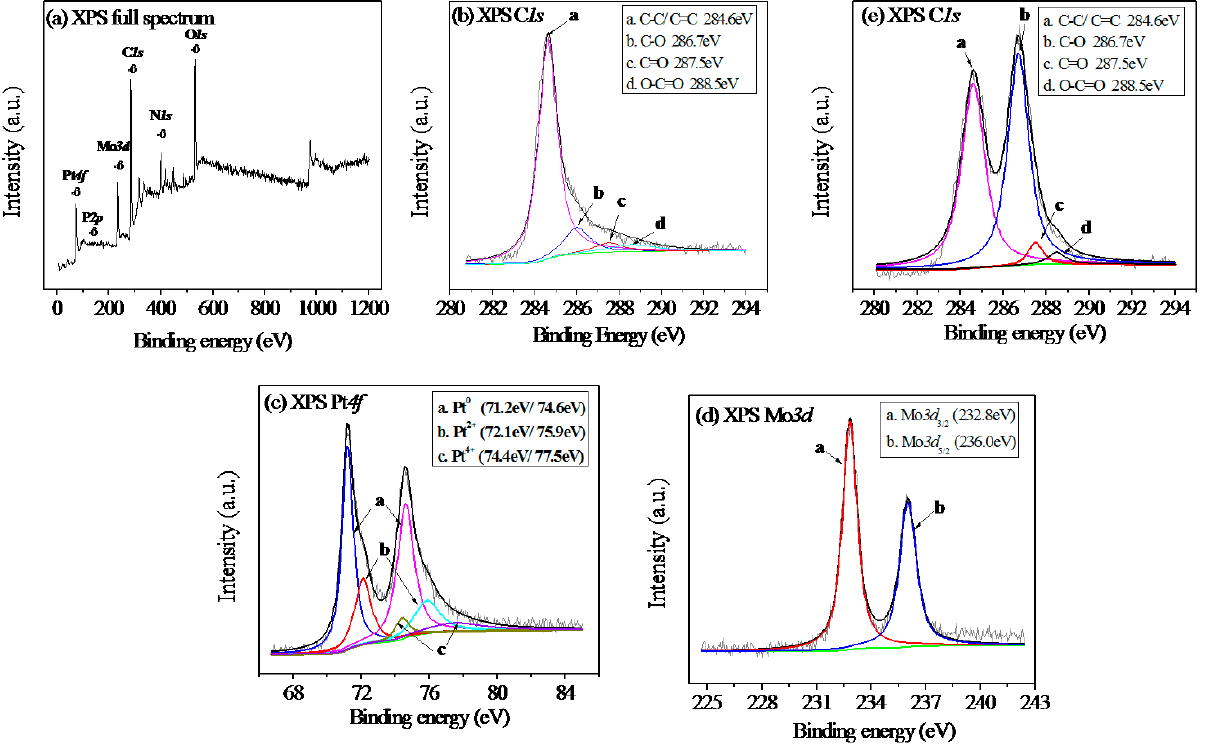
Figure 3. XPS spectra: ( a ) Full scan of PMo 12 -Pt/rGO composites; ( b ) ( e ) C1s spectrum of PMo 12 -Pt/rGO composites and GO; ( c ) ( d ) Pt 4f and Mo 3d spectrum of PMo 12 -Pt/rGO